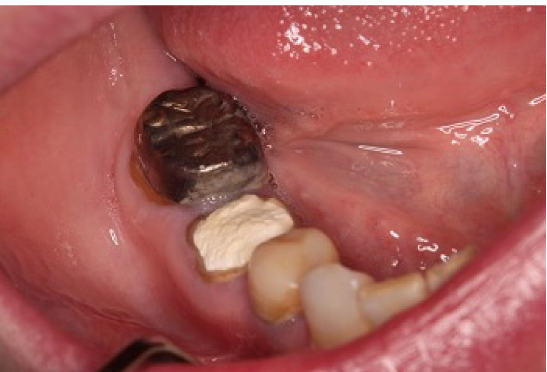
Figure 3. Intraoral photographs taken at the first visit to our hospital. The first molar was temporarily sealed with